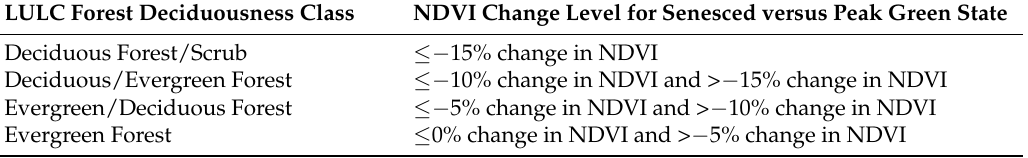
Table 2. Decision rules used in classification of forest deciduousness, based on comparison of MODIS monthly (32-day) NDVI data for peak senescence versus peak greenness observed during the dry season